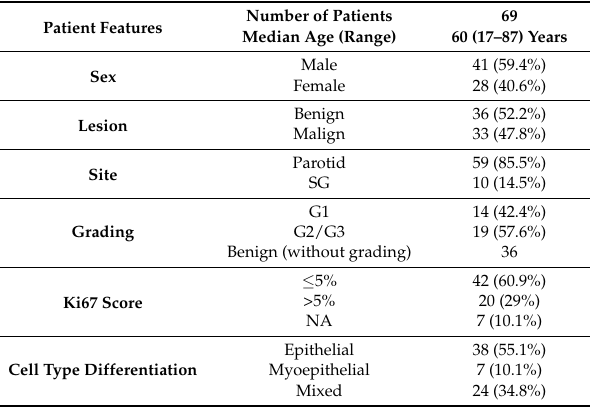
Table 1. Main Clinical-Pathological